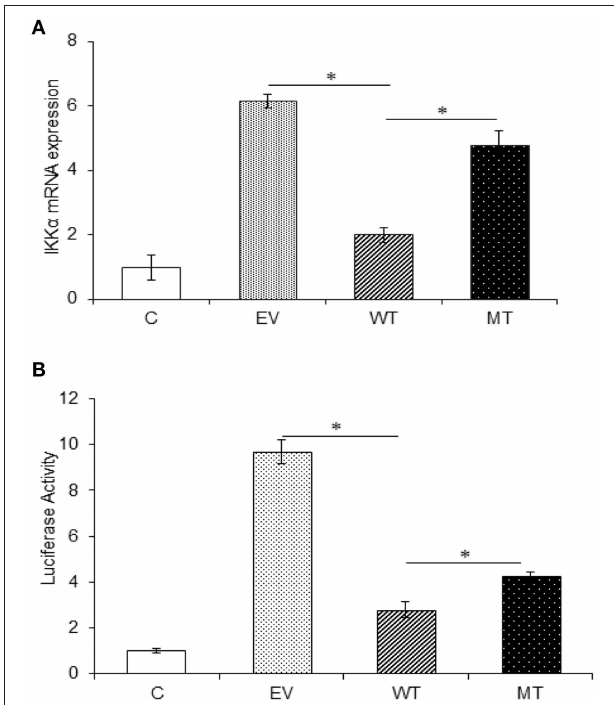
FIGURE 10 | IKK α expression is negatively regulated by miR-223. IKK α showed a decreased expression in the presence of miR-223, which was again increased to a significant point in the presence of mutated form of miR-223. (A) miR-223 and IKK α were co-transfected in HT29 cells for 48h. After 48h, RNA was isolated and reverse transcribed to investigate the mRNA expression of IKK α through qRT-PCR. GAPDH gene was used as an internal reference. (B) miR-223 and IKK α were co-transfected in HT29 cells along with pRL-TK control plasmid, which was used as internal reference, for 24h. After 24h, the dual luciferase reporter assay was performed to access the luciferase activity corresponding to IKK α expression. P < 0.05 were statistically significant. * Denotes level of significance. * p ≤ 0.05. C, untransfected control; EV, empty vector; WT, wild type; MT, mutant. Bars represent standard error of the mean